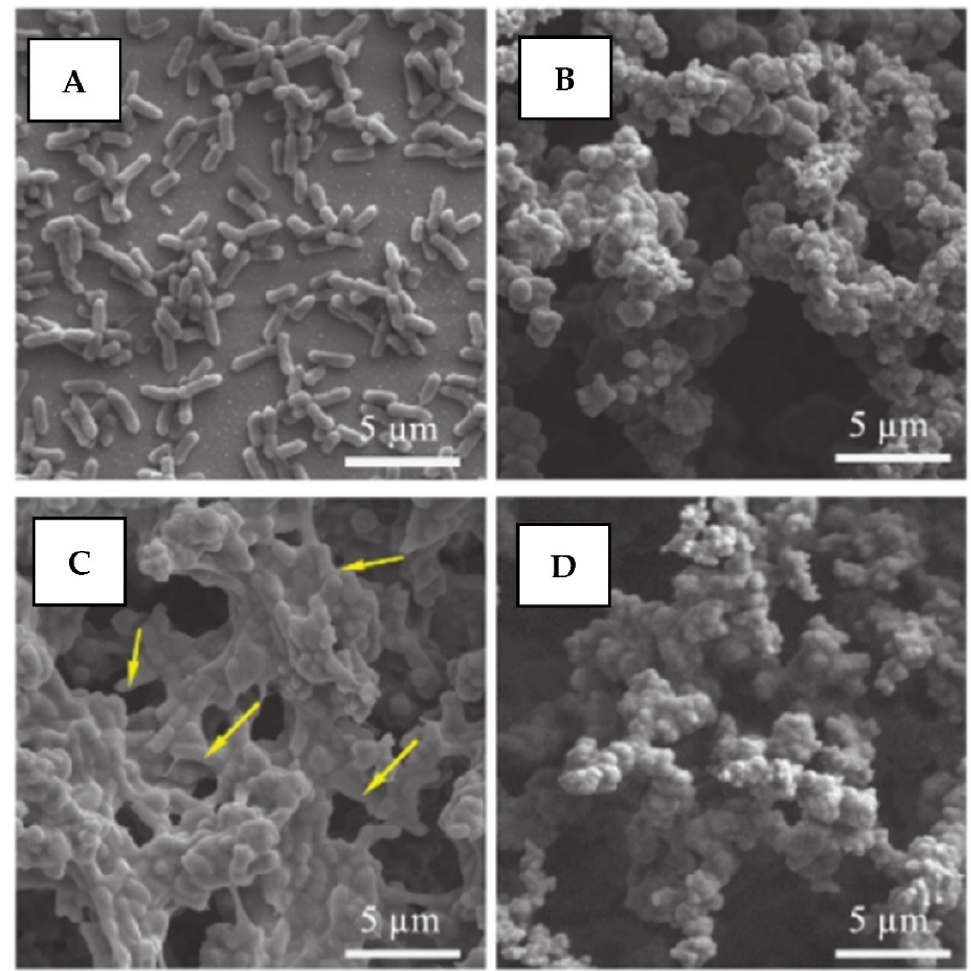
Figure 20. Scanning electron microscopy images of silicone/polypyrrole sample surface after the interaction with E. coli for 15 h: ( A ) control sample (Au covered with a thin copper film); ( B ) without and ( C ) with the application of EF; ( D ) E. coli contaminated sample surface (the same as in ( C )) after simple rinsing with water. Reprinted with permission from ref. [142]. Copyright 2019 Wiley.